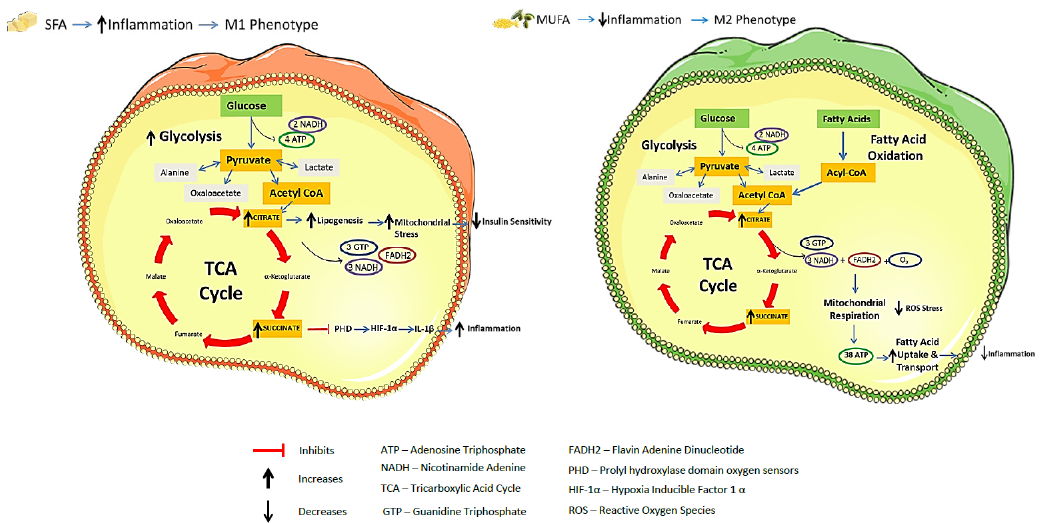
Figure 3. Integration of metabolism and immune responses. Obesity and SFA drive an M1 pro-inflammatory phenotype in macrophages which favours glycolysis for ATP generation and leads to TCA cycle fragmentation with a break at the succinate dehydrogenase step. This break in the TCA cycle results in increased succinate and citrate accumulation. Citrate accumulation impedes insulin sensitivity by increasing lipogenesis and mitochondrial stress. Succinate inhibits PHD, stabilizing HIF-1 α leading to activation of the pro-inflammatory cytokine IL-1 β . While MUFA and PUFA drive an anti-inflammatory M2 phenotype which favours the more energy efficient process of